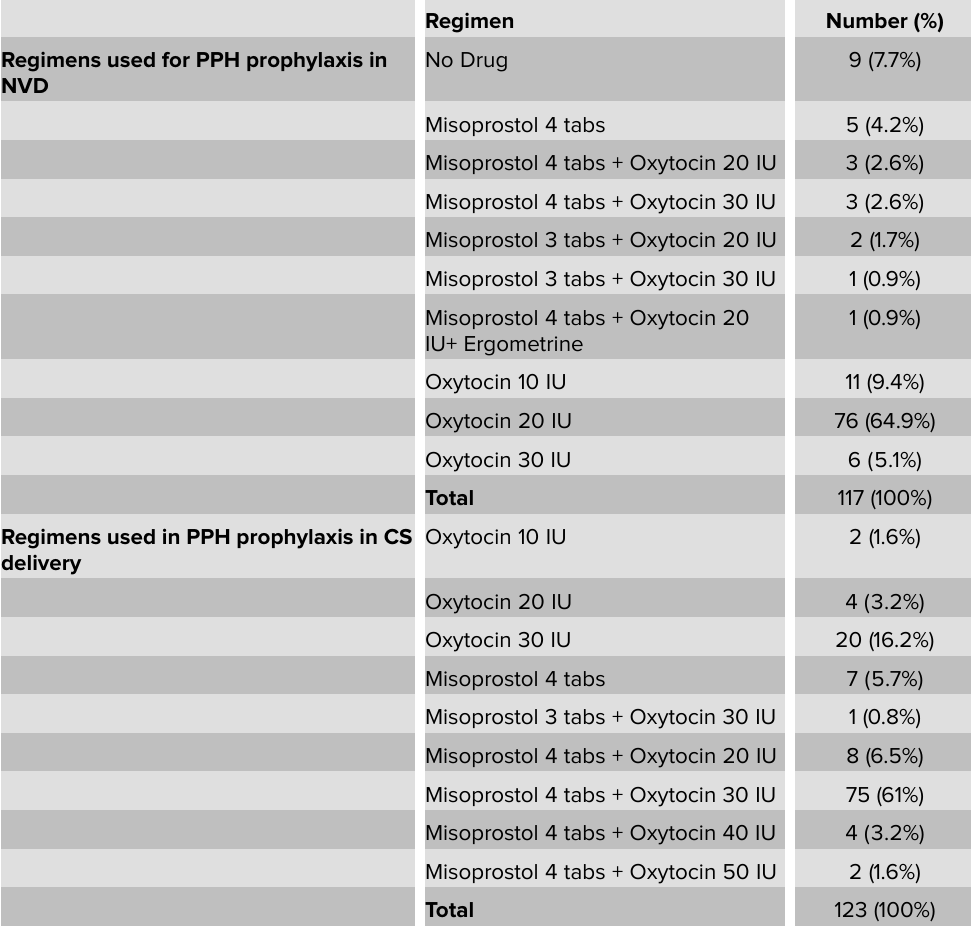
TABLE 4: Different regimens used after normal vaginal delivery (NVD) and after caesarian section (CS) as postpartum hemorrhage prophylaxis (PPH) Regimen Number (%) Regimens used for PPH prophylaxis